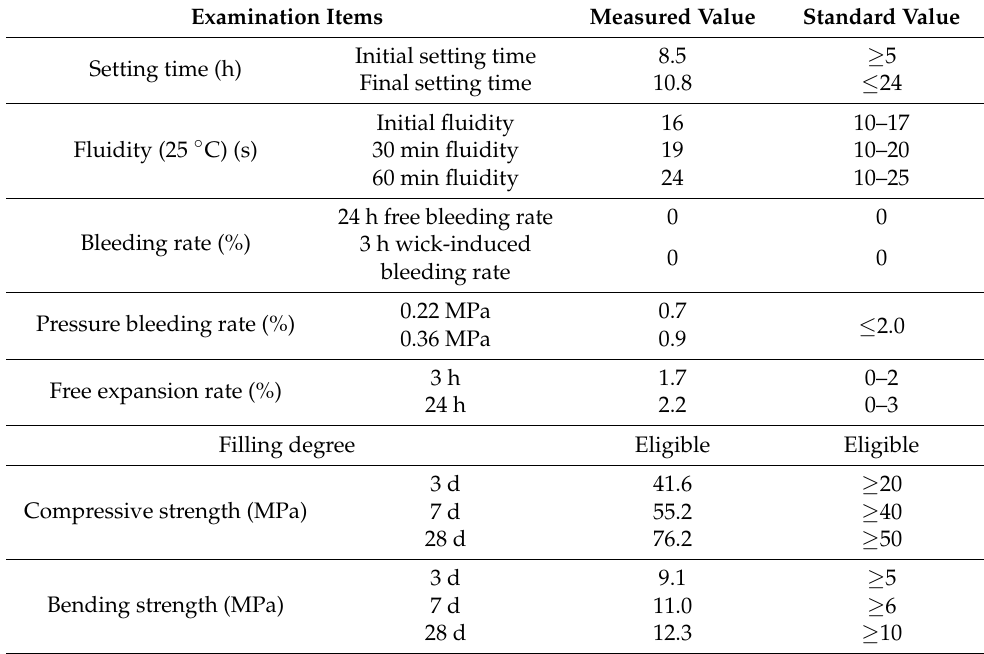
Table 1. The technical indexes of